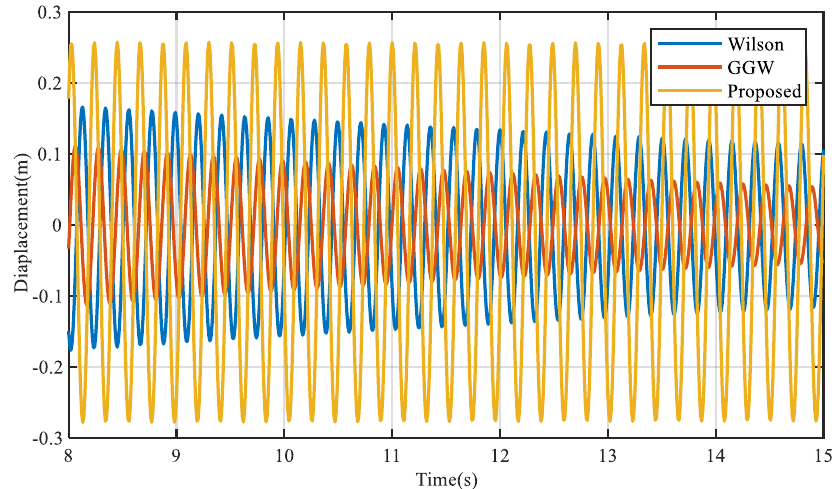
Figure 22. Displacement responses of Point A within 8–15 s using the Wilson method, Bathe method, and the proposed method when Δ t = 0.01s. and the proposed method when ∆ t = 0.01 s.